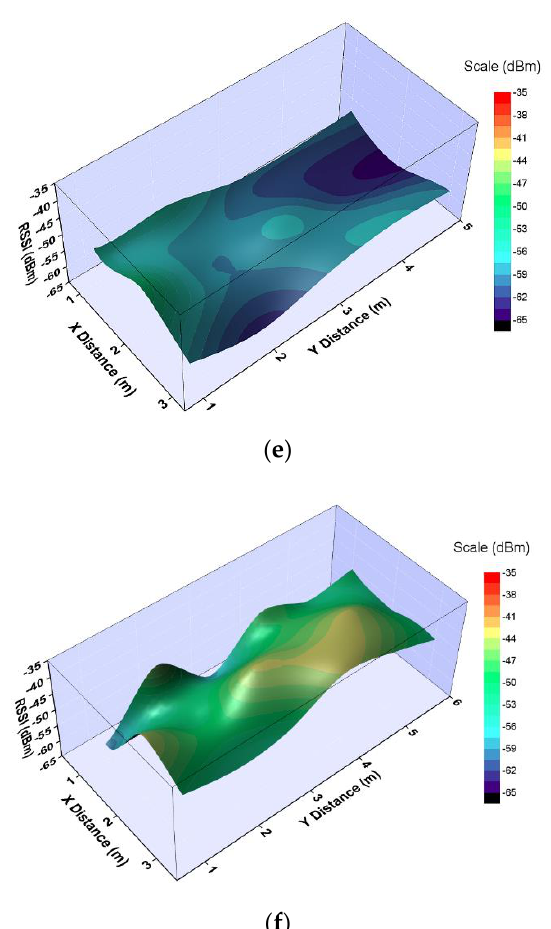
Figure 8. RSSI: ( a ) Simple drawing of the configuration of the test setup; ( b ) Photograph of the test setup in the semi-anechoic chamber; ( c ) Distribution in the semi-anechoic chamber in the free space; ( d ) Distribution in the shielded room in the free space; ( e ) Distribution in the semi-anechoic chamber when the antenna is on the semi-solid phantom; ( f ) Distribution in the shielded room when the antenna is on the semi-solid phantom.